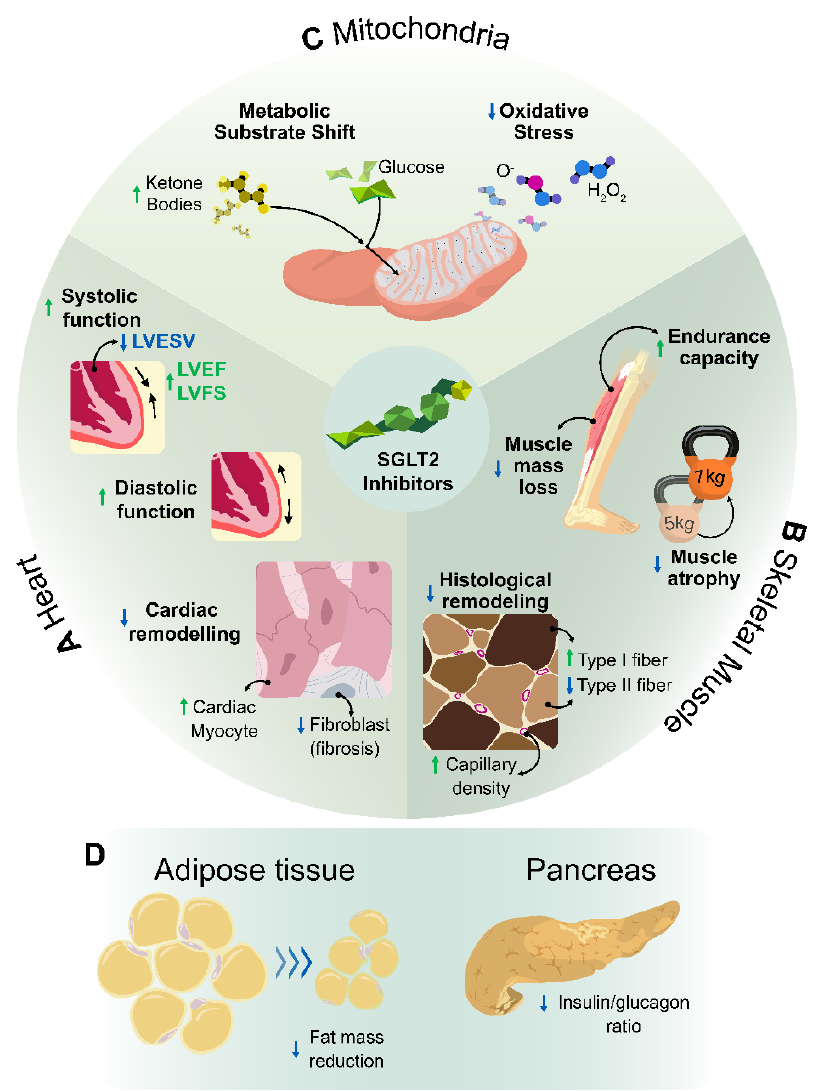
Figure 3. Potential effects of SGLT2 inhibitors within different organ systems that influence exercise capacity in HF beneficially. This figure depicts potential benefits of sodium-related glucose transporter 2 (SGLT2) inhibitor treatment on the heart, skeletal muscle, and metabolism, potentially improving exercise tolerance in heart failure. These benefits include: ( A ) improvement of cardiovascular performance, including improvement of systolic function, improvement of diastolic function, and attenuation of cardiac remodeling; ( B ) improvement of skeletal muscle function, including amelioration of skeletal muscle remodeling, an increase in muscle strength, preservation of skeletal muscle mass, and improvement of muscle endurance capacity; ( C ) beneficial metabolic and mitochondrial effects, including improvement of mitochondrial function, a metabolic substrate shift leading to a beneficial change in cardiac energy production, and a decrease in oxidative stress; ( D ) a reduction in bodyweight and a decrease in the insulin–glucagon ratio.